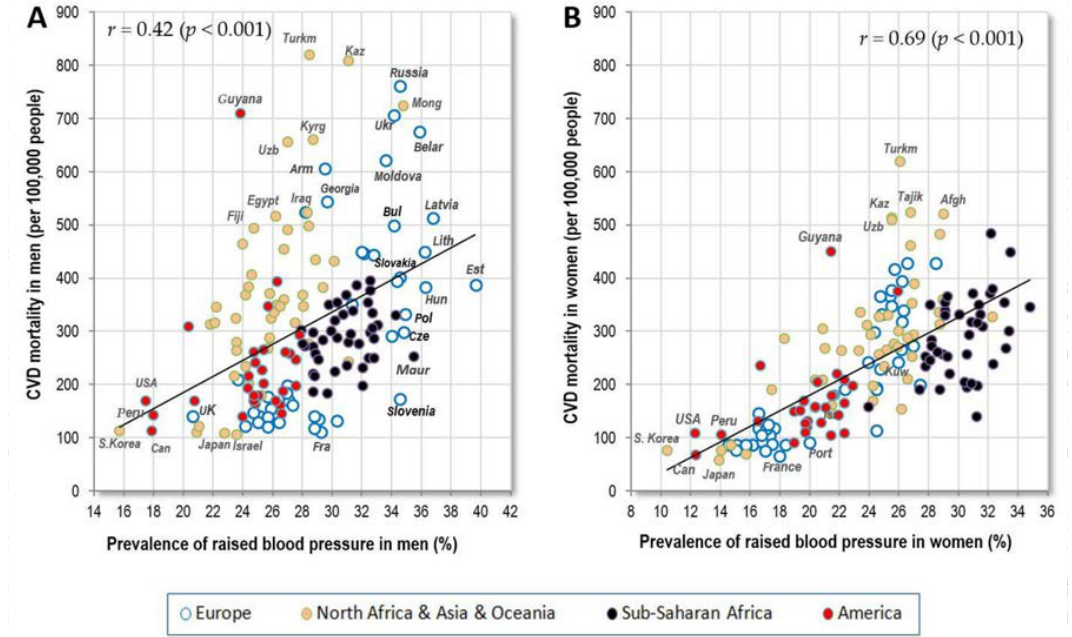
Figure 2. ( A ) Relationship between the prevalence of men’s raised blood pressure (%; WHO, 2010) and CVD mortality (WHO, 2012); ( B ) Relationship between the prevalence of women’s raised blood pressure (%; WHO, 2010) and CVD mortality (WHO,